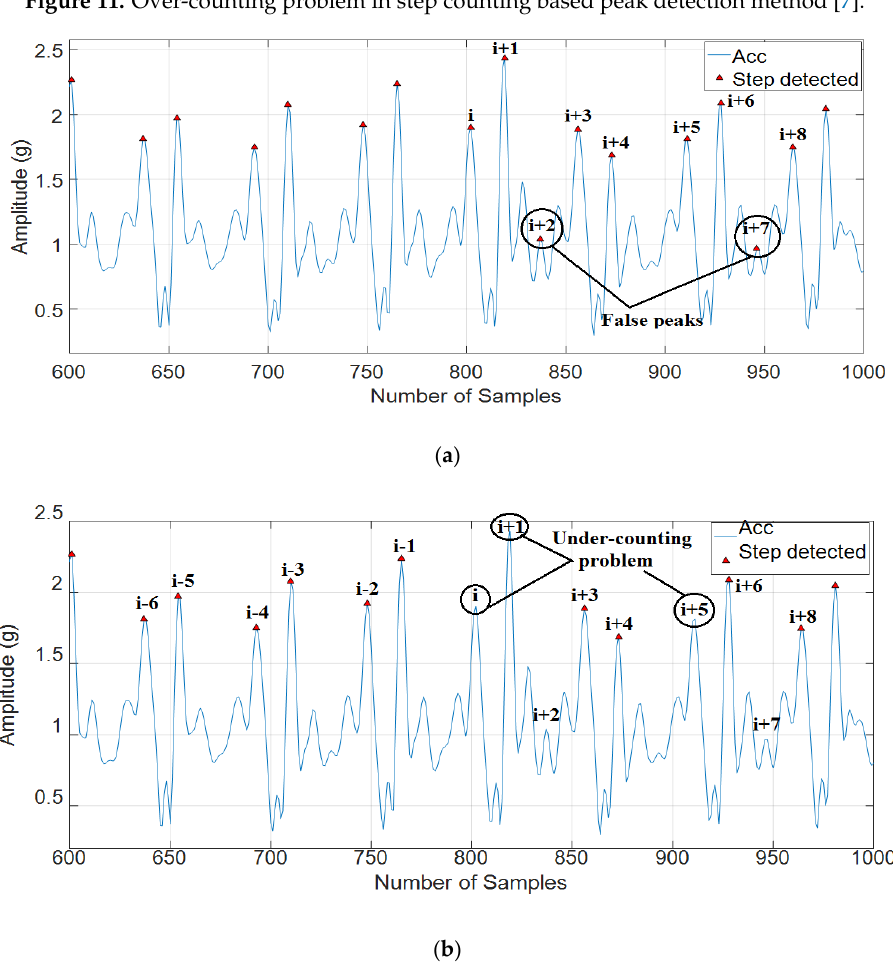
Figure 12. Analyze step counting based on periodicity, similarity, and continuity method: ( a ) False peaks detected in step counting after using periodicity and continuity features; and ( b ) Under-counting problem after using similarity feature.